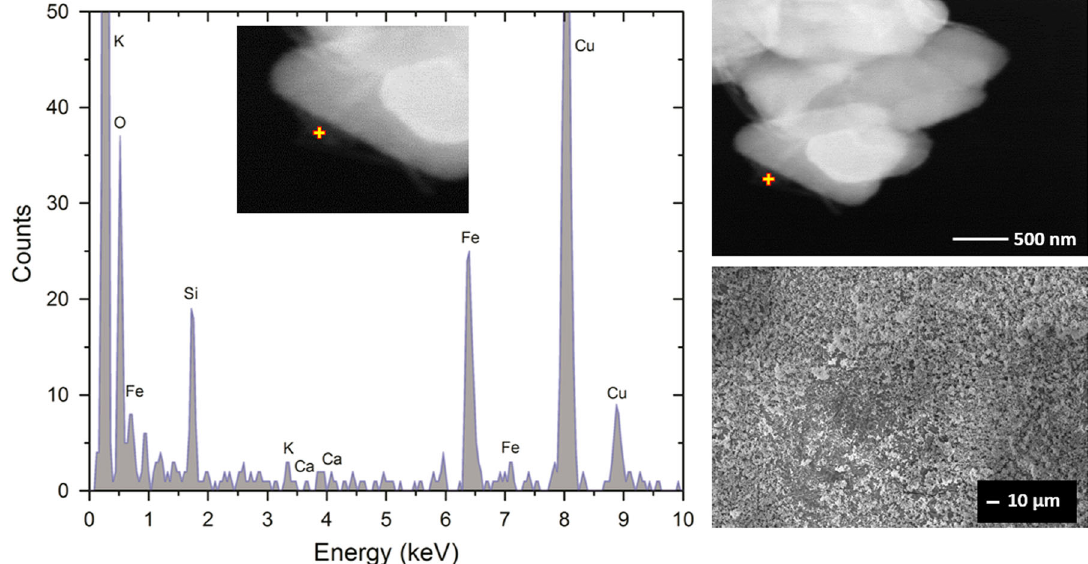
Fig. 9 TEM image and EDS analysis of a magnetite grain. Upper right image shows the TEM analysis of the grain with the corresponding EDS spectra on the left image. SEM of the magnetite grains is shown on the bottom right